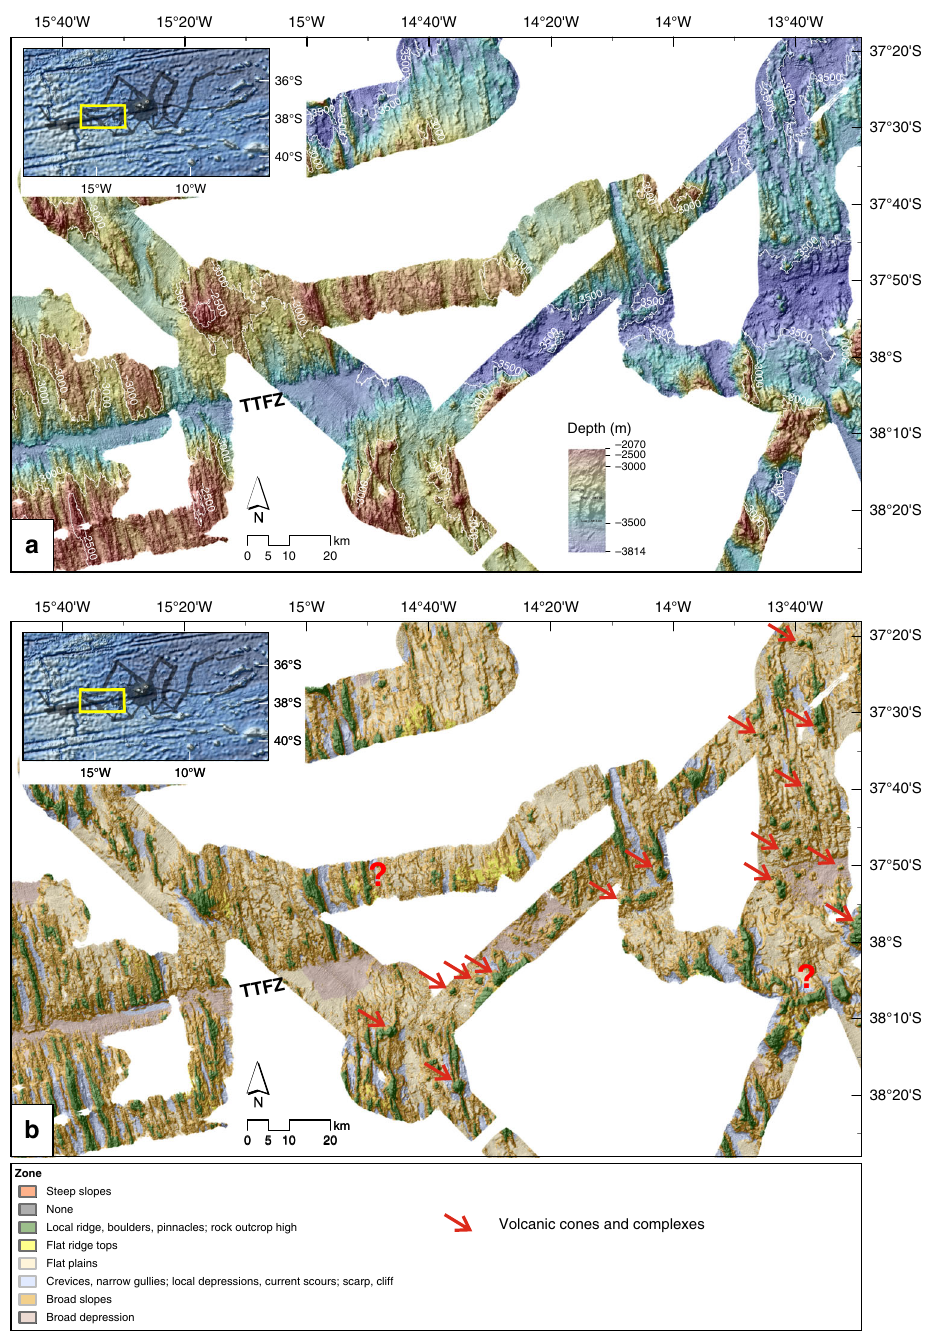
Fig. 6 Bathymetry and Benthic Terrain Model of the western volcanic cones. a Bathymetry for the area of the western volcanic cones. The hillshade is illuminated by an azimuth of 315°. b Benthic Terrain Model. A number of circular features and W – E orientated ridges can be identi fi ed that are interpreted as relatively young volcanic cones and complexes (red arrows). TTFZ Tristan da Cunha Transform Fault And Fracture Zone System. Unclassi fi ed greyscale seabed backscatter is shown in Supplementary Fig.